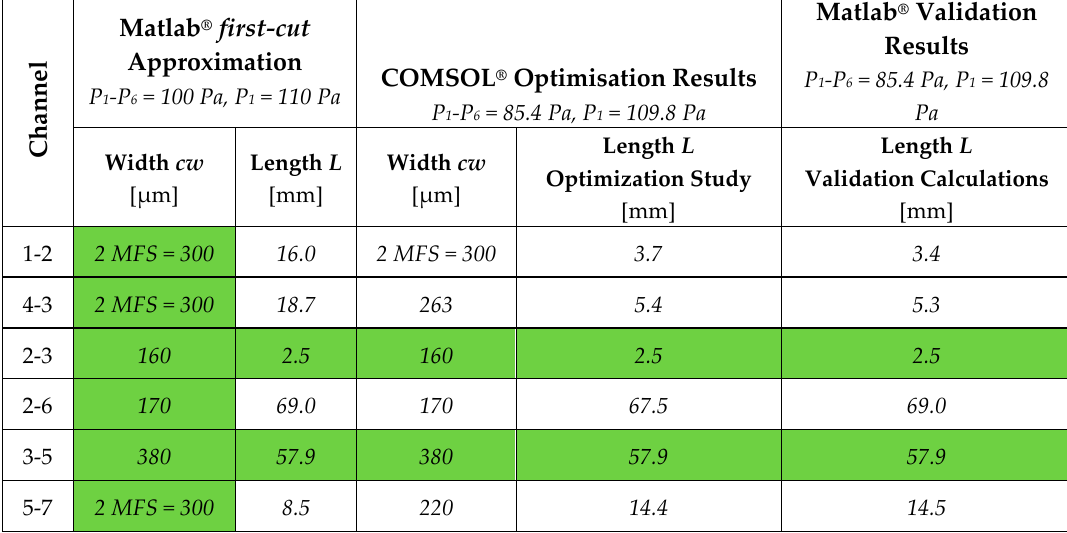
Table 1. Microfluidic network geometrical parameter results for the modular pressure and flow rated balanced unit cell.